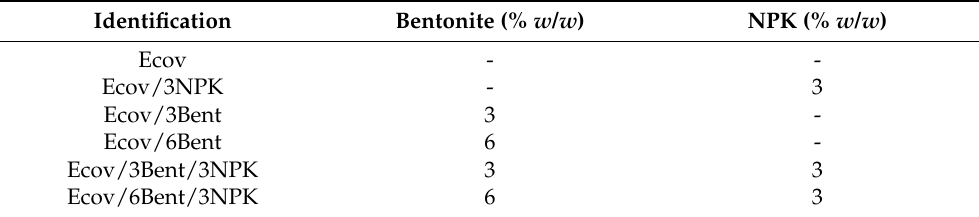
Figure 1. Schematic illustration of: ( a ) preparation of concentrates; ( b ) production of filament; ( c ) prototype printing. Table 1. Filament compositions.